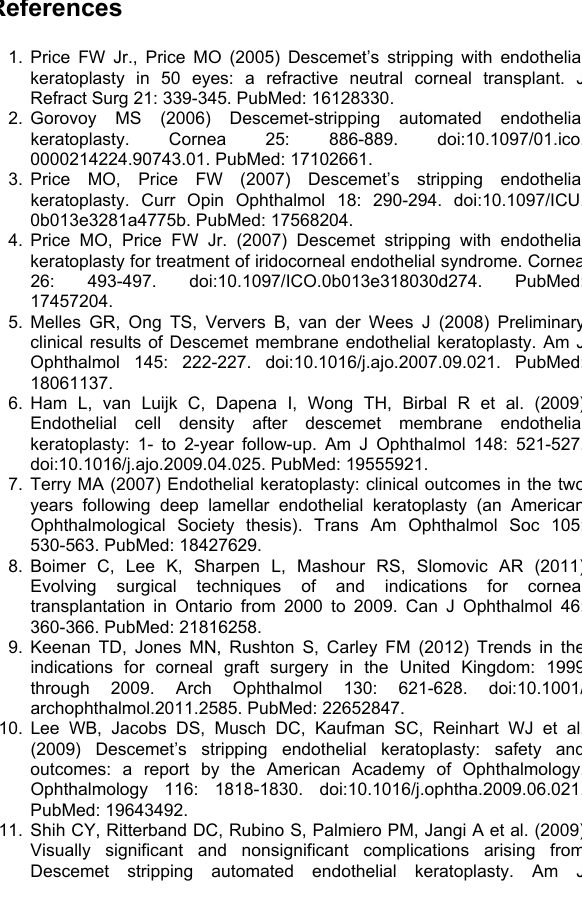
Figure S1. Images of SEF obtained by in vivo confocal microscopy and by combined immunofluorescence and second harmonic generation (SHG) imaging microscopy for the same patient with bullous keratopathy. ( A ) In vivo confocal microscopy. Fibroblastic cells were observed. The asterisk indicates basal cells, confirming that the optical slice was located in the basal cell layer of the corneal epithelium and not in the anterior stroma. ( B ) Immunofluorescence–SHG imaging microscopic analysis of a frontal slice of the cornea obtained at the time of penetrating keratoplasty. Green, α- smooth muscle actin (αSMA); blue, nuclei; magenta, SHG backward signal (collagen-derived weak signal); cyan, SHG forward signal (oriented collagen fiber–derived signal). αSMA- positive fibroblastic cells (myofibroblasts) were observed within accumulated collagen. ( C ) Sectional immunofluorescence– SHG imaging microscopic analysis, with the arrowhead indicating the location of the slice in (B). Note that αSMA- positive cells are located not underneath but above Bowman’s layer.